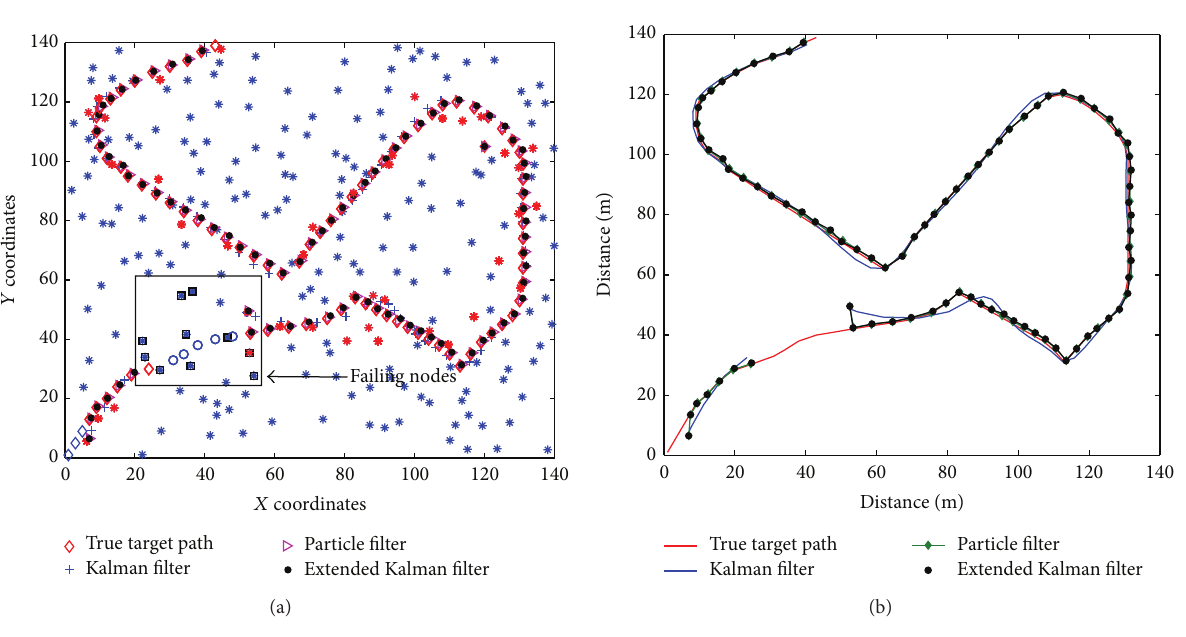
Figure 5: Loss of target due to failing